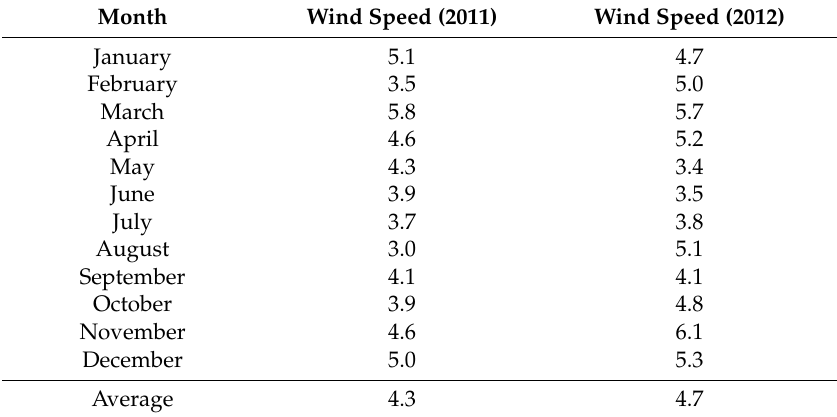
Table 4. Monthly average wind speed from 2011 to